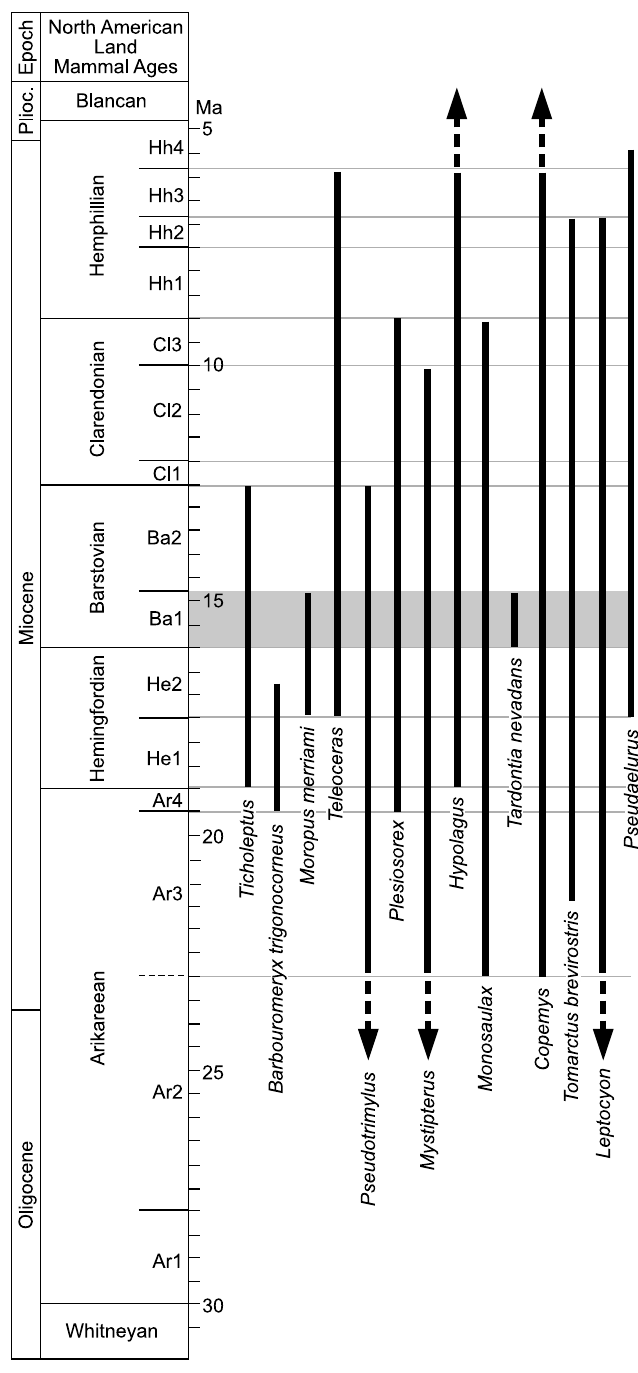
Fig. 9. Biochronologic ranges of land mammals of the Eastgate local fauna (horizontal grey zone). North American Land Mammal ages and subages and absolute time scale in Ma adapted from Tedford et al. (2004: fig. 6.2). Dashed lines and arrows indicate that the temporal range for the taxon con- tinues beyond the Miocene. Ranges for taxa taken from Munthe (1998); Lander (1998); Martin (1998); Dawson (2008); Flynn and Jacobs (2008a, b); Gunnell et al. (2008); Lindsay (2008); Prothero and Liter